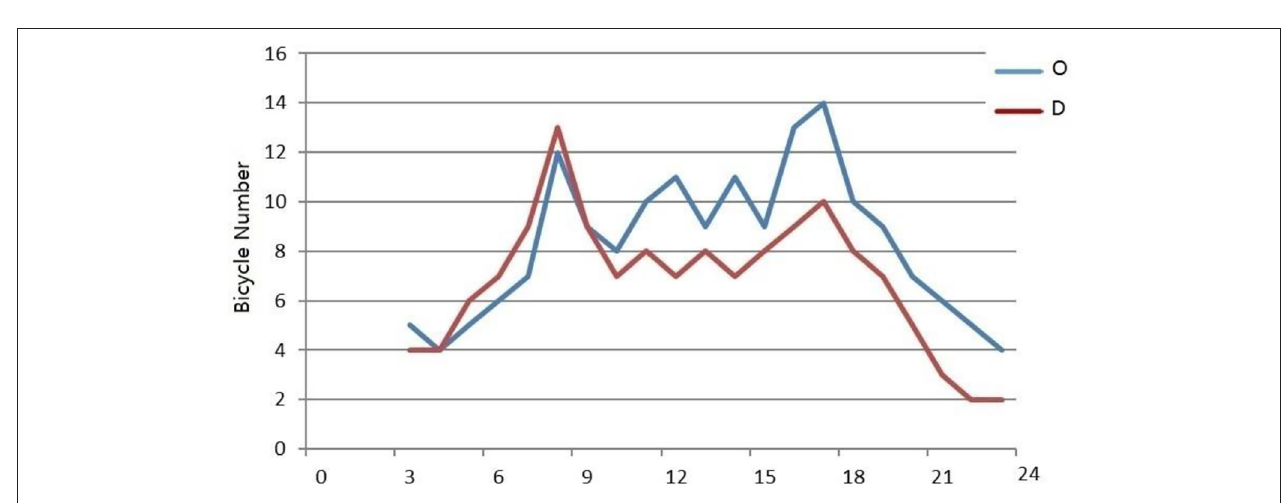
FIGURE 8 | Prediction of bicycle OD quantity in Fenghuang